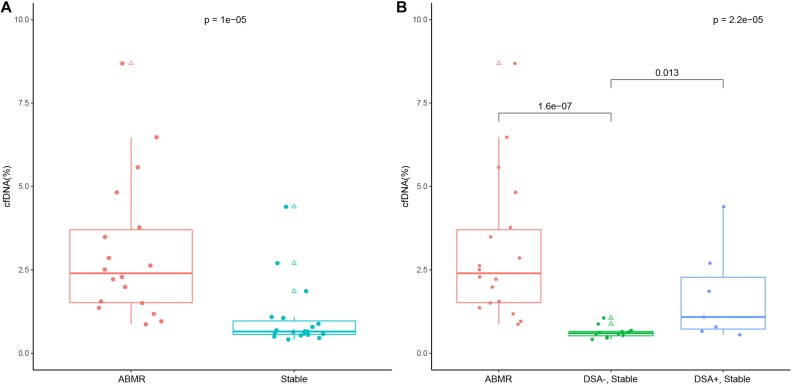
Donor-derived cell free DNA (cfDNA) fraction in the ABMR group and the stable allograft group (A), and in the ABMR group, the DSA-positive and negative stable allograft subgroup (B). The lower and upper whisker of the box whisker plot represent 5% and 95%, and the upper and lower border of the box represent 25th and 75th percentile and the mid transverse line represents the median. Solid dots represent true values and triangles represent outliers (>95th percentile and <5th percentile).